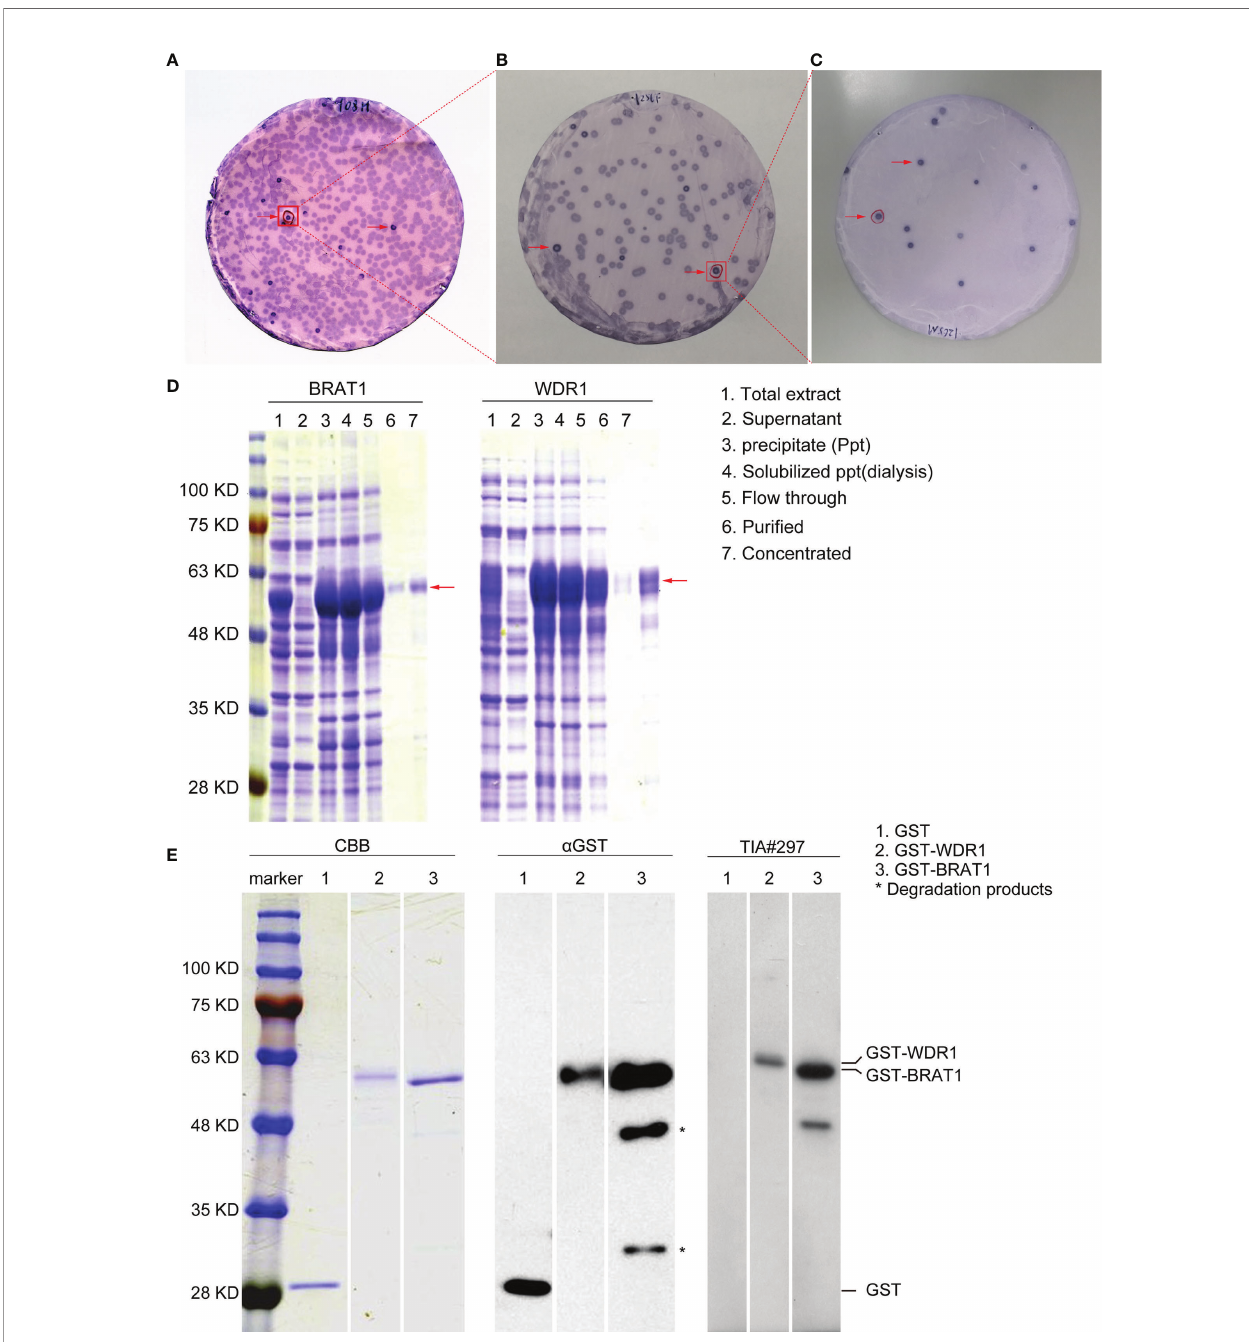
FIGURE 1 | Recognition and identi fi cation of BRAT1 and WDR1 using serum of TIA patients. (A) Recombinant expression cloning proteins were detected by SEREX in sera from TIA patients. positive phage clones were marked by red arrows. (B) Positive clones obtained from above were rescreened to obtain monoclonality. (C) Positive clones from B were recloned to obtain monoclonality. (D) Antigenic proteins BRAT1 and WDR1 were succeeded in puri fi cation from precipitate fraction. (E) GST-BRAT1, GST-WDR1 and GST proteins were electrophoresed through SDS-polyacrylamide gels followed by staining with Coomassie Brilliant Blue (CBB), Western blotting using anti-GST ( a GST), or sera of TIA patient [TIA#297]. The degradation products of GST-BRAT1 were marked by asterisks